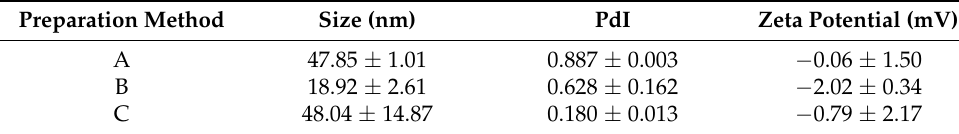
Table 1. Mean size, polydispersity index (PdI) and zeta potential (mean ± SD). Preparation Method